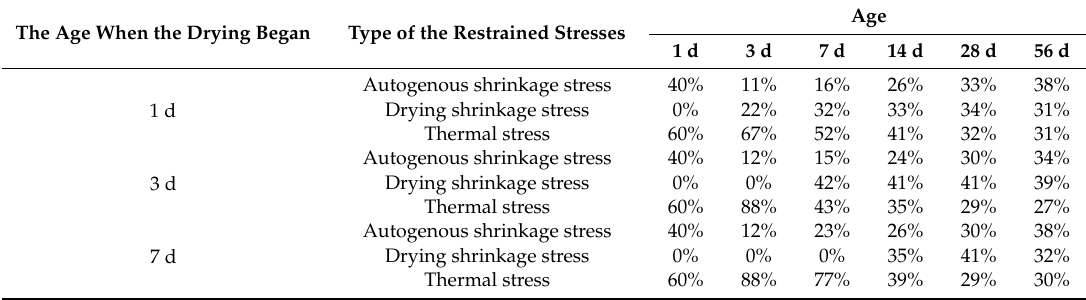
Table 6. The proportions of autogenous shrinkage stress, drying shrinkage stress and thermal stress in total restrained stress under U-streel restraint and di ff erent drying